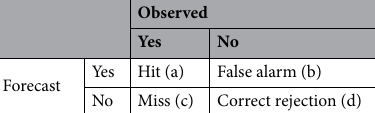
Table 2. Contingency table.